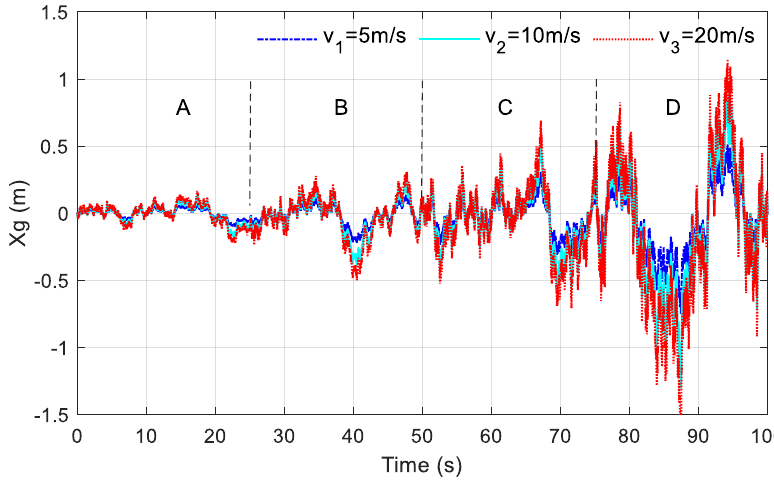
Figure 2. Comparison of road displacement changes at different speeds of A–D grade road.